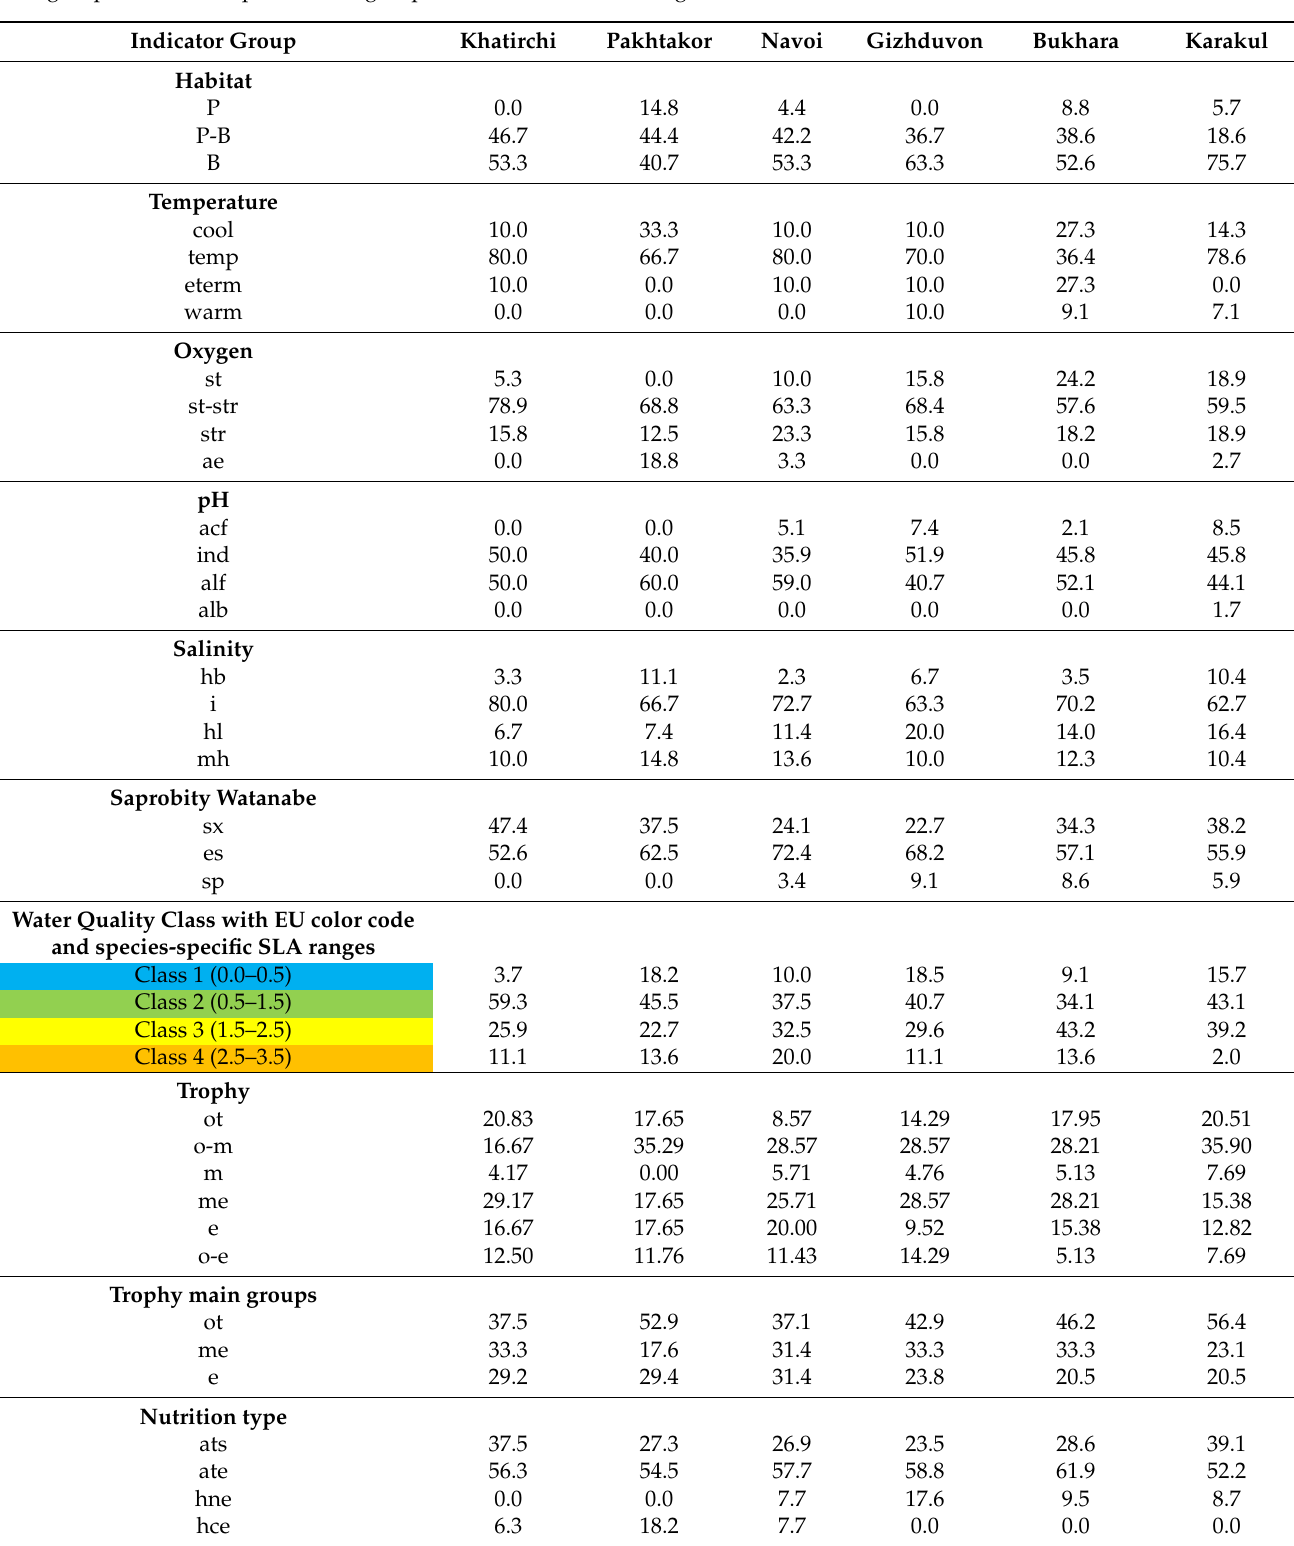
Table 3. Percent of bioindicator groups in each studied site community of the Zarafshan River, 2009–2015. The ecological groups’ order in respect of each group indicator value